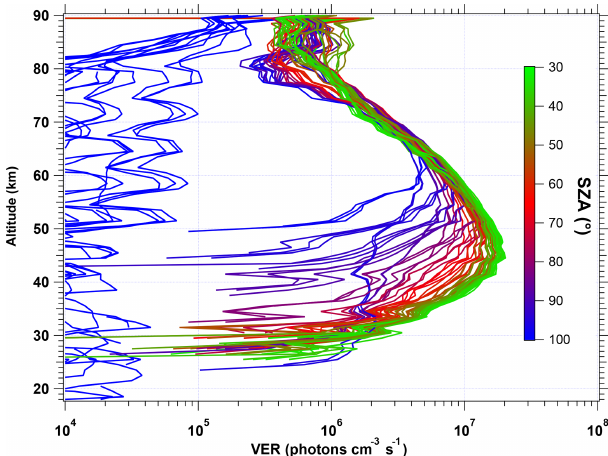
Figure 6. VER profiles of airglow at 1.27µm retrieved from SCIA- MACHY limb data for 1 January 2007 (80 profiles). The colour scale represents the SZA. For the lowest SZA values probed by SCIAMACHY (33 ◦ ), the peak VER is 2 × 10 7 photonscm − 3 s − 1 around 45km. At large SZA values, the emission is present only at high altitudes ( > 80km). Above 90 ◦ , there is almost no signal for